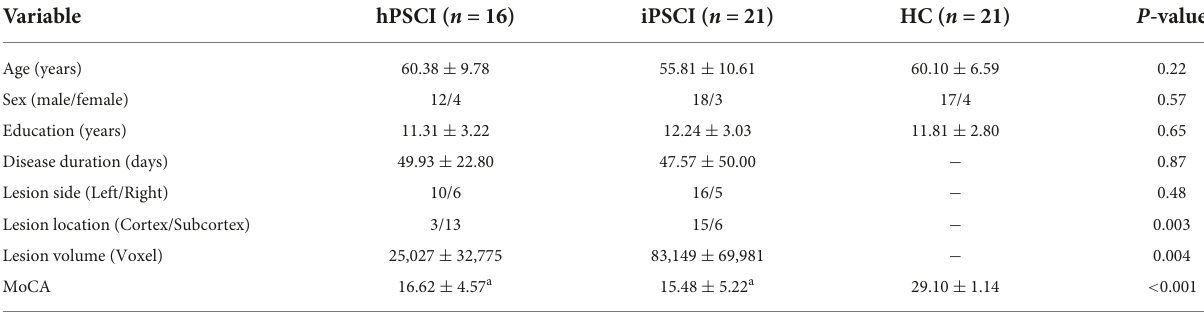
TABLE 1 Demographic, clinical, and neuropsychological data in cognitive impairment group after hemorrhagic stroke (hPSCI group), the cognitive impairment group after ischemic stroke (iPSCI group), and healthy control group (HC group).